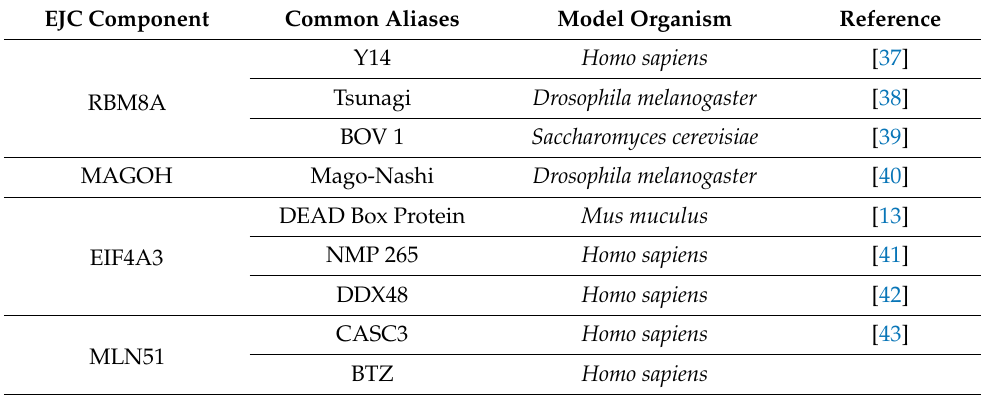
Table 1. Common aliases used to describe each of the major EJC components discussed in this paper as RBM8A, MAGOH, EIF4A3, and MLN51. Included are the model organisms used to find in which species the alias was first identified or used with corresponding